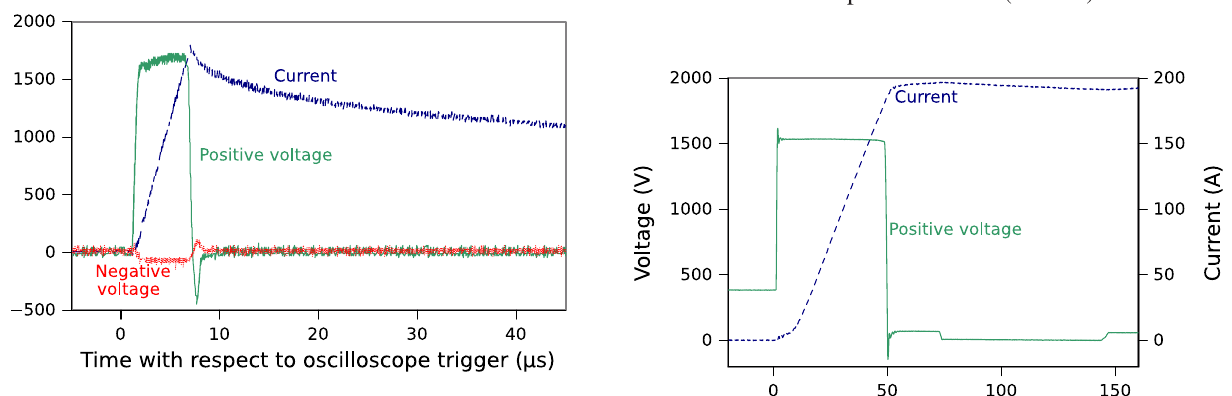
FIG. 13. Measured power supply waveforms for 250 A de- manded flat-top current, with 30 m of cable and the magnet replaced with a short circuit: Positive-side output voltage (green solid trace); negative-side output voltage (red dotted trace); output current (blue dashed trace).